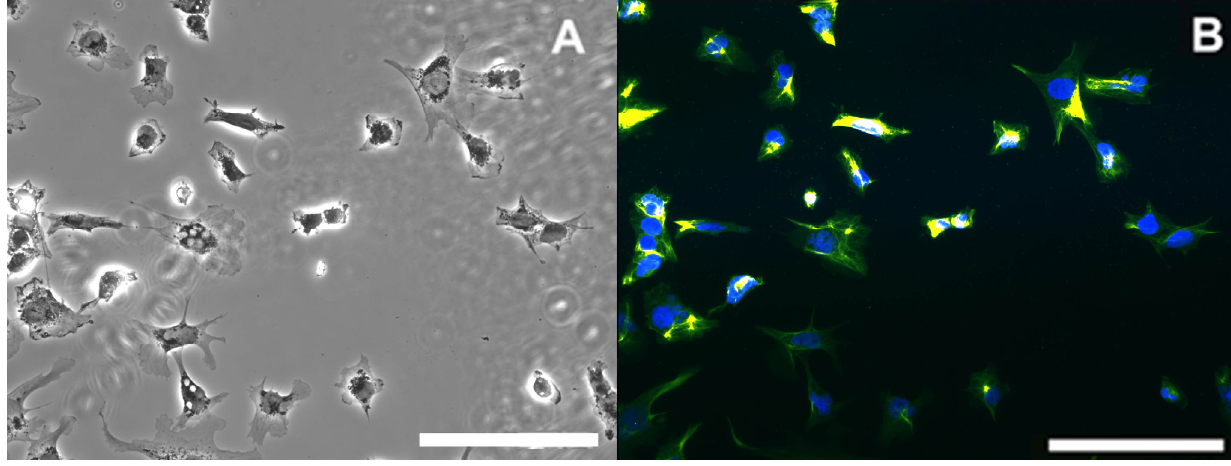
Figure 1. NT2 neural progenitor cells. ( A ) Phase contrast images showing NT2 neural progenitor cells; ( B ) Expression of NPC (neural progenitor cells) marker, nestin, co-stained with 4',6-diamidino-2-phenylindole (DAPI) show 100% positive nestin cells. Bars correspond to 500